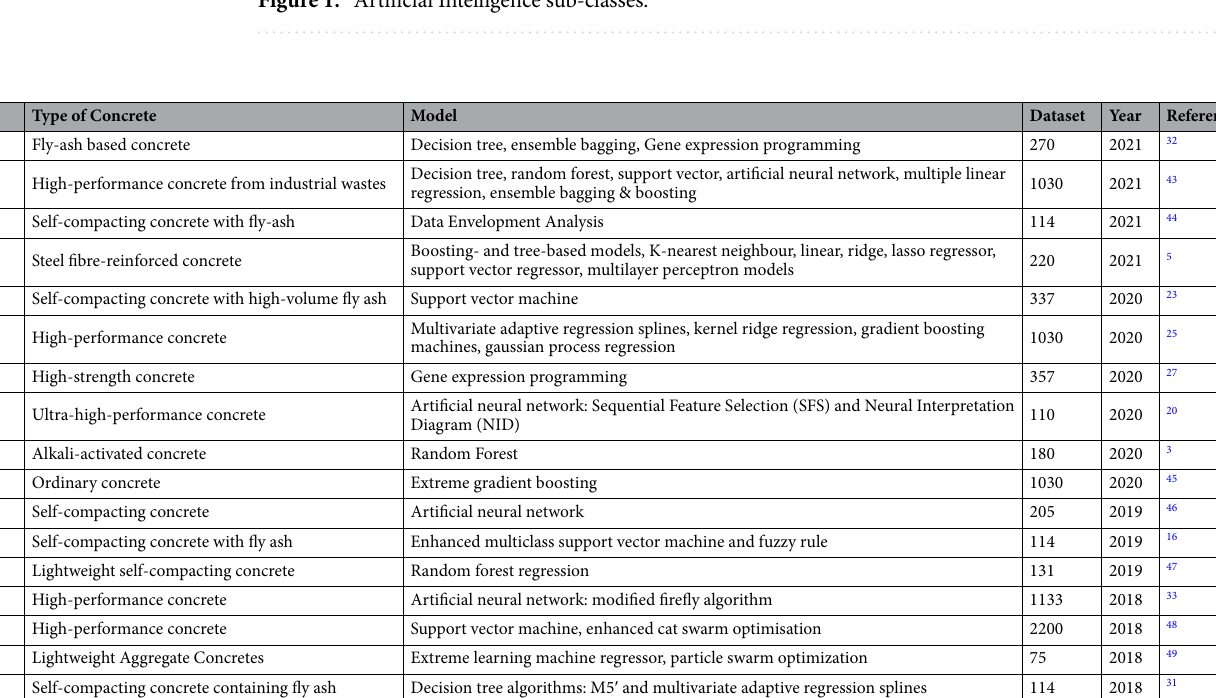
Figure 1. Artificial Intelligence sub-classes.